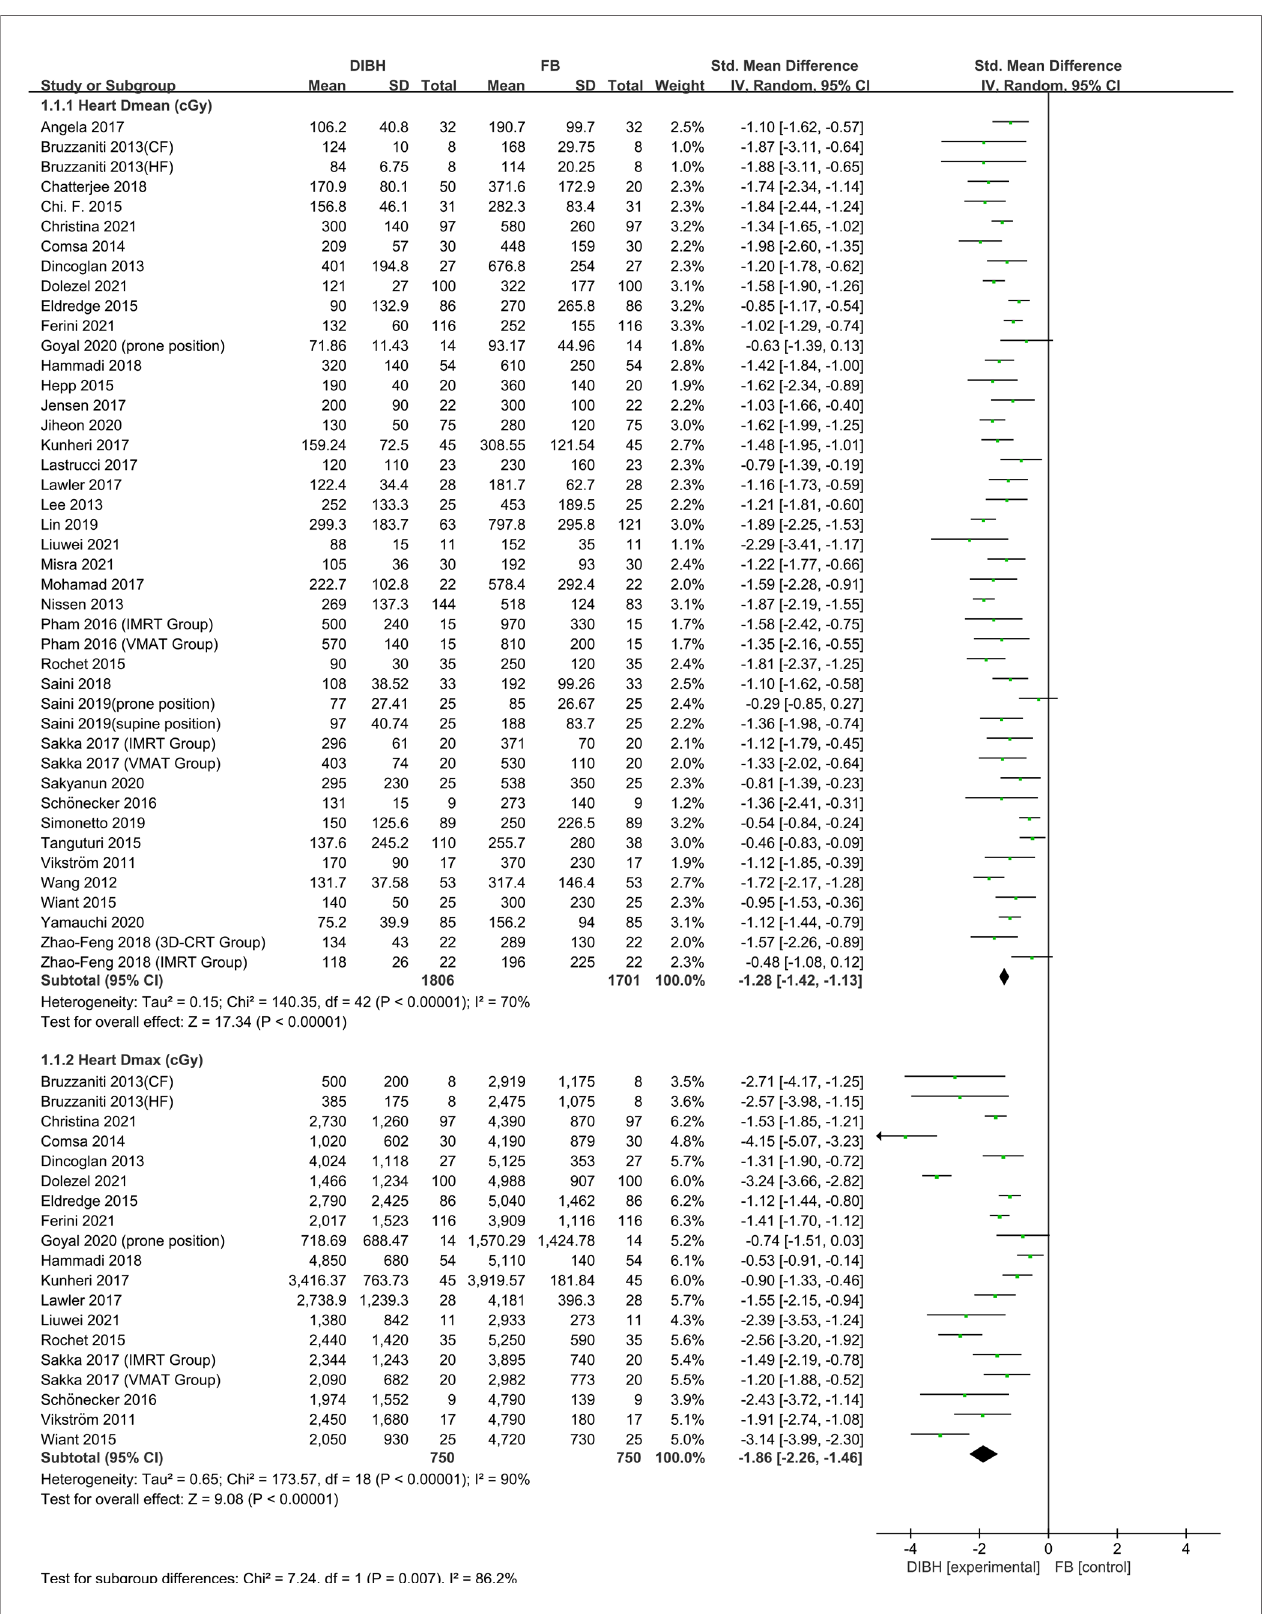
FIGURE 2 | Forest plot of heart dose ( D mean and D max) between the DIBH group and FB